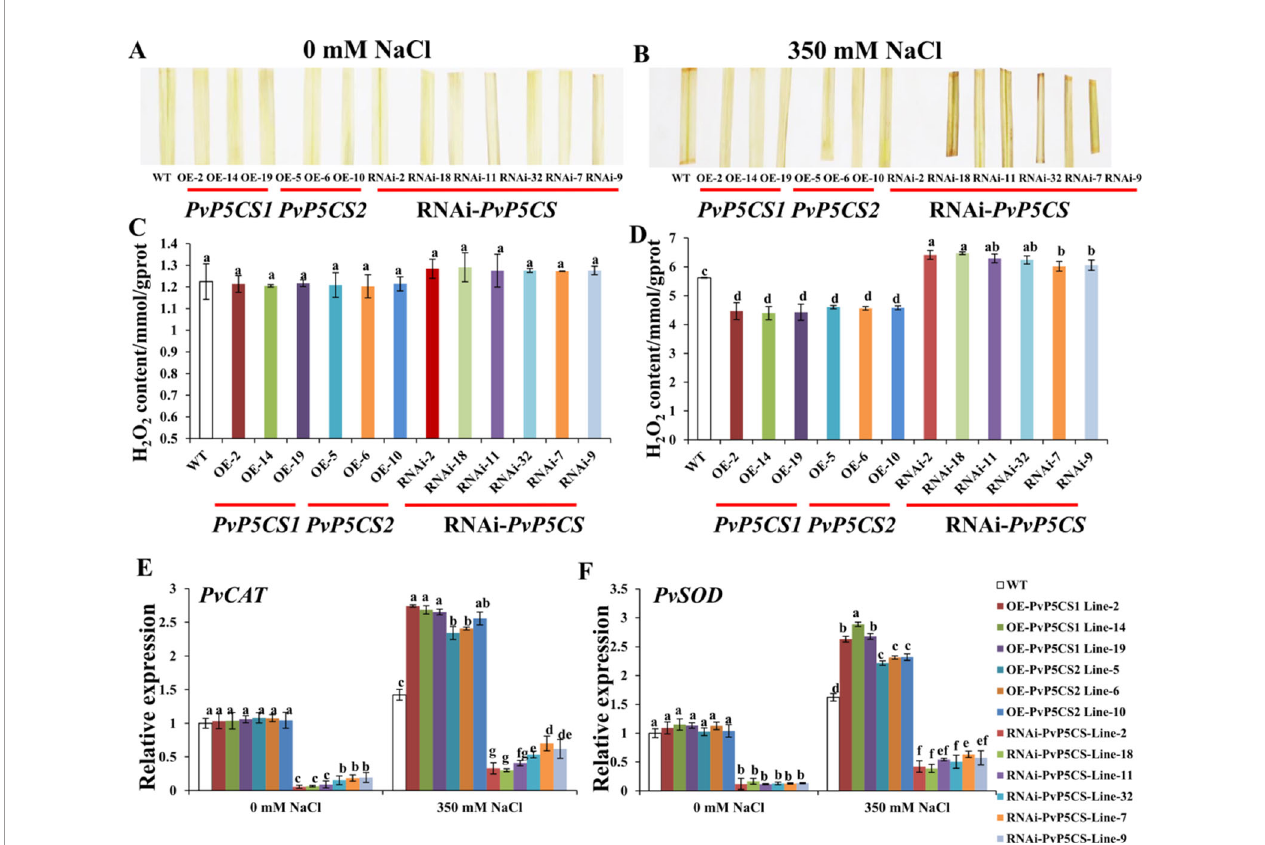
FIGURE 6 | Overexpression of PvP5CS genes in switchgrass positively regulates the induction of ROS scavengers and membrane transporters, and reduces H 2 O 2 accumulation under 350 mM NaCl treatment. Color of detached leaves after staining with diaminobenzidine (DAB) in wild type, PvP5CS OE and RNAi transgenic plants under 0 mM (A) and 350 mM (B) NaCl treatment. H 2 O 2 content in the leaves of wild type, PvP5CS OE and RNAi transgenic plants under 0 mM NaCl (C) and 350 mM NaCl (D) treatment. Relative expression levels of PvCAT (E) and PvSOD (F) in wild type, PvP5CS OE and RNAi transgenic plants under 0 and 350 mM NaCl treatment. Data are mean values of three biological repeat, and signi fi cance of treatments was tested at the P < 0.05 level (one way ANOVA, Dunnett's